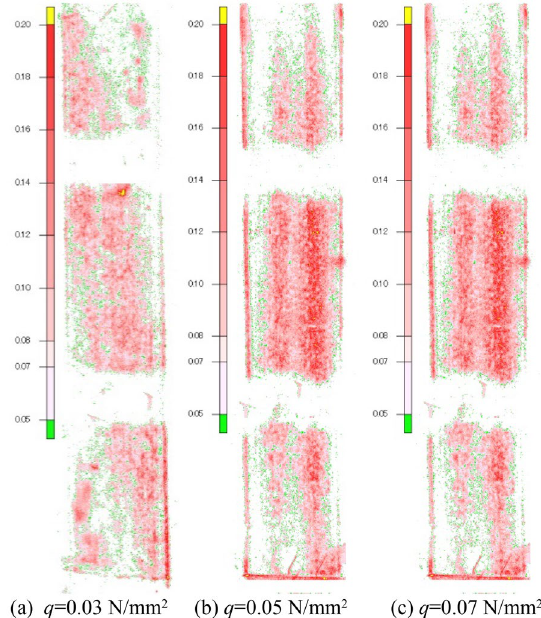
Figure 14 Experimental results of applying uniform force: a q N/mm 2 ; b q 0.05 N/mm 2 ; c q 0.07 N/mm = =